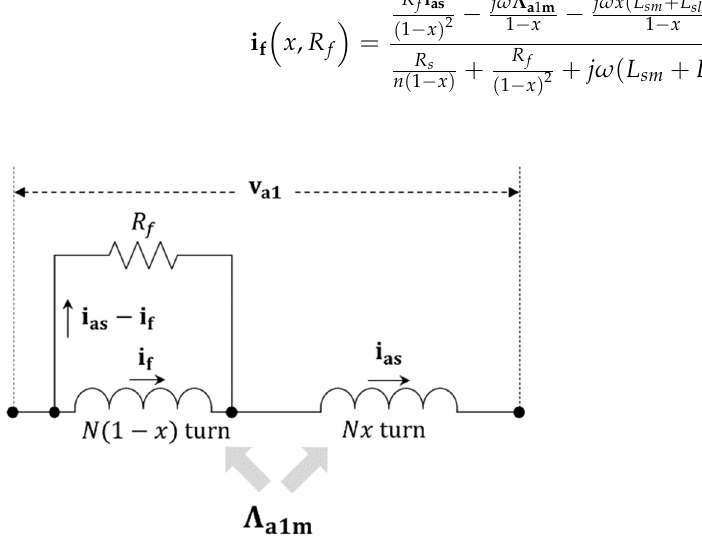
Figure 2. Circuit of 𝑎 (cid:2869) winding with the ITF.